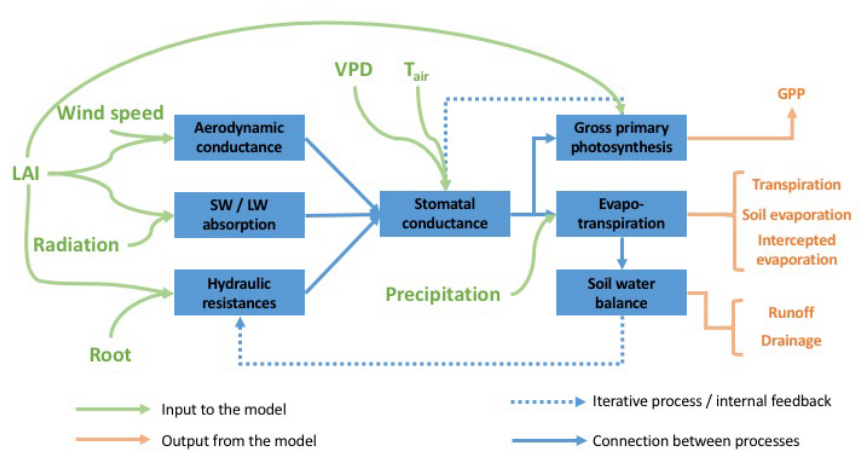
Figure 1. Schematic of ACM-GPP-ET showing its inputs, outputs and how its processes are interconnected. The blue boxes indicate distinct process groupings within the model framework. Green arrows are inputs to the model, while orange arrows indicate model output (i.e. carbon and water fluxes). Blue arrows show the interconnections between the various